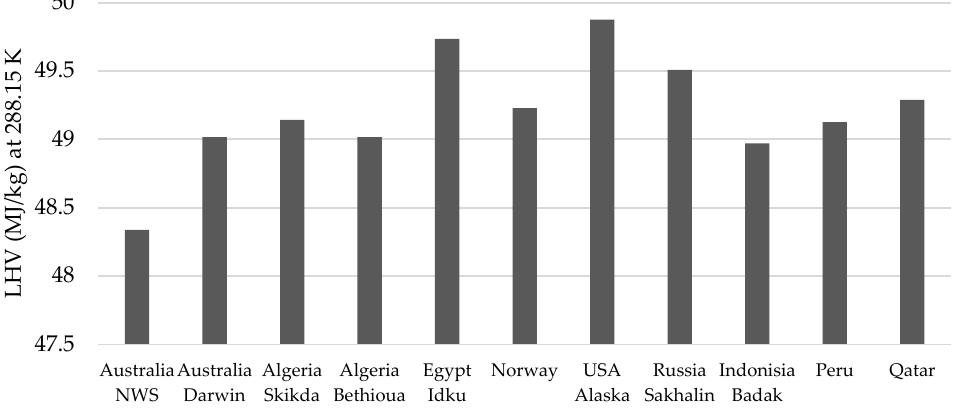
Figure 2. Variations in LHV per Region.